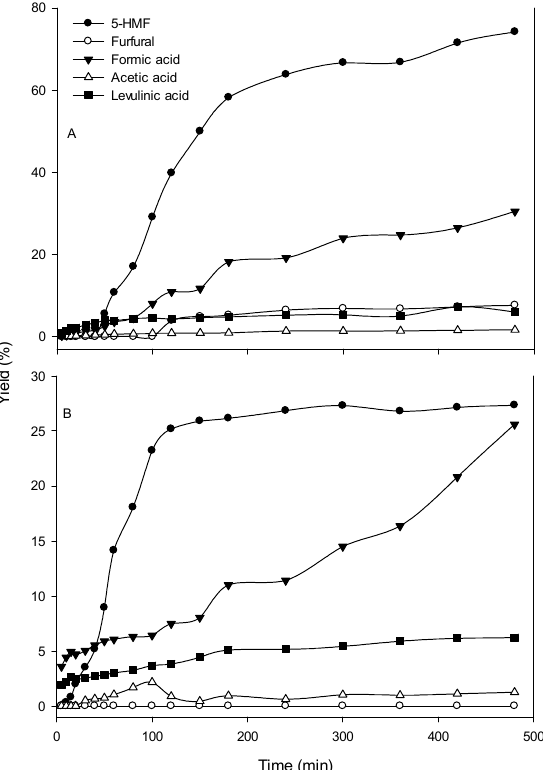
Figure 1. Reaction results of fructose ( A ) and glucose ( B ) catalyzed by [TMG]BF 4 . Conditions: fructose or glucose (0.5 g), [TMG]BF 4 (0.25 g), dimethylsulfoxide (60 mL), 160 ◦